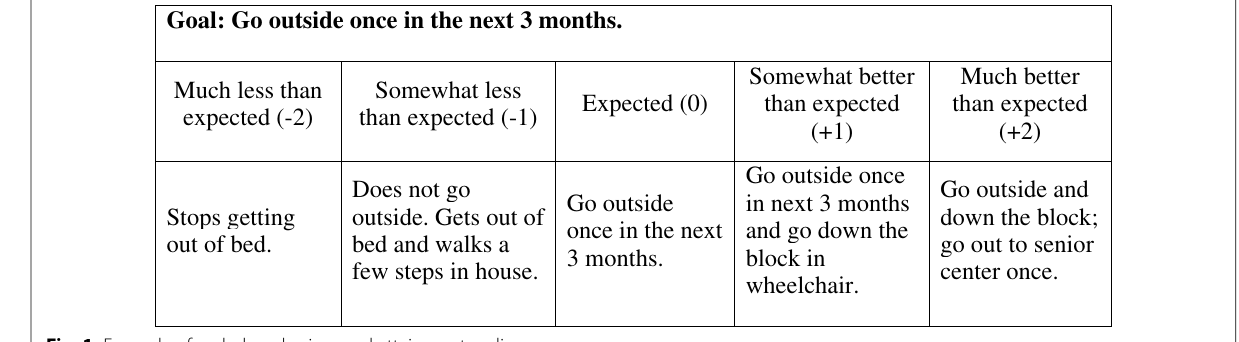
Fig. 1 Example of scaled goal using goal attainment